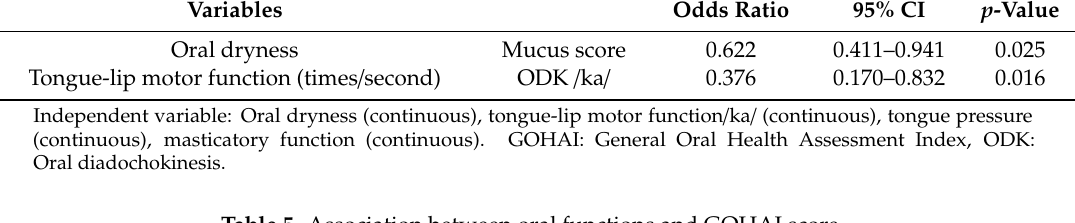
Table 5. Association between oral functions and GOHAI